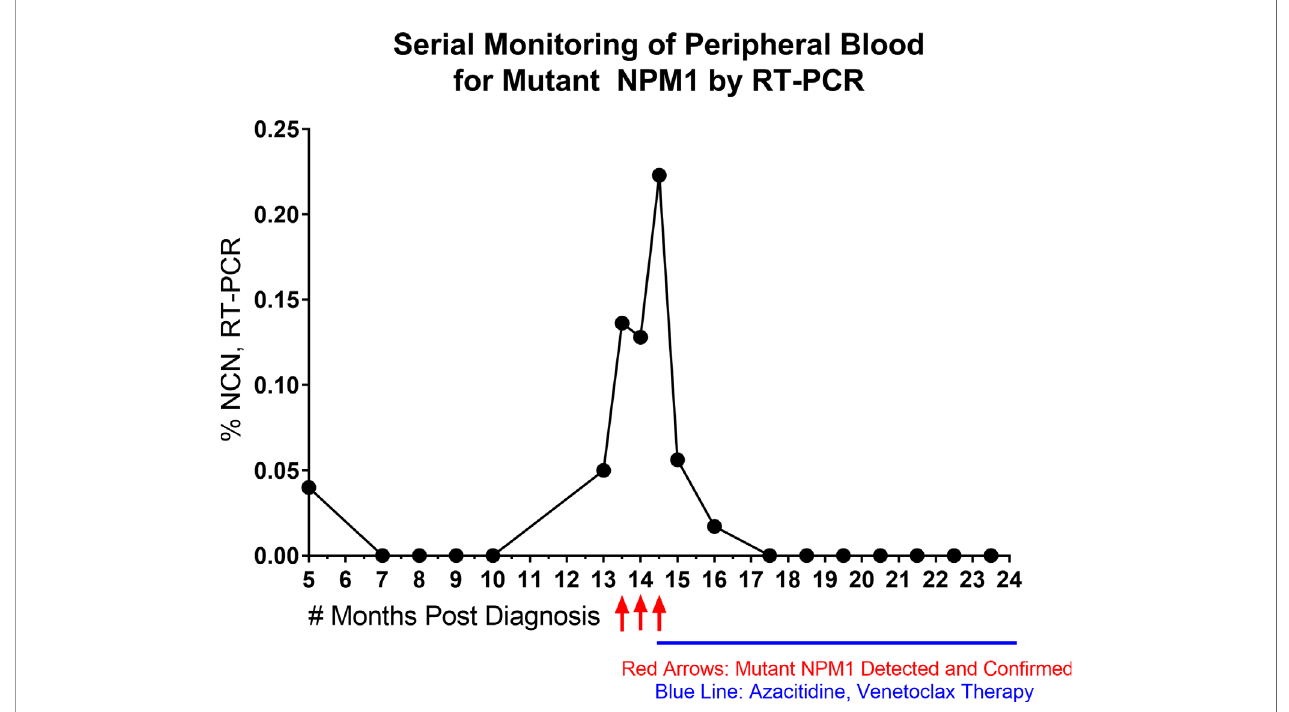
FIGURE 3 | Time Course of Serial, Quantitative RT-PCR of Peripheral Blood. NPM1 (Type A) mutant transcript monitoring by RT-PCR (%NCN) from peripheral blood is shown over time for a patient. Red arrows indicate detection and con fi rmation of unexpected increase in NPM1 mutant transcripts. Blue line indicates initiation and duration of azacitidine/venetoclax therapy. Shortly after the initiation of azacitidine therapy, the NPM1 mutant transcripts continued to rise, but then decreased during further into azacitidine treatment and remained undetectable with continuation of azacitidine/venetoclax